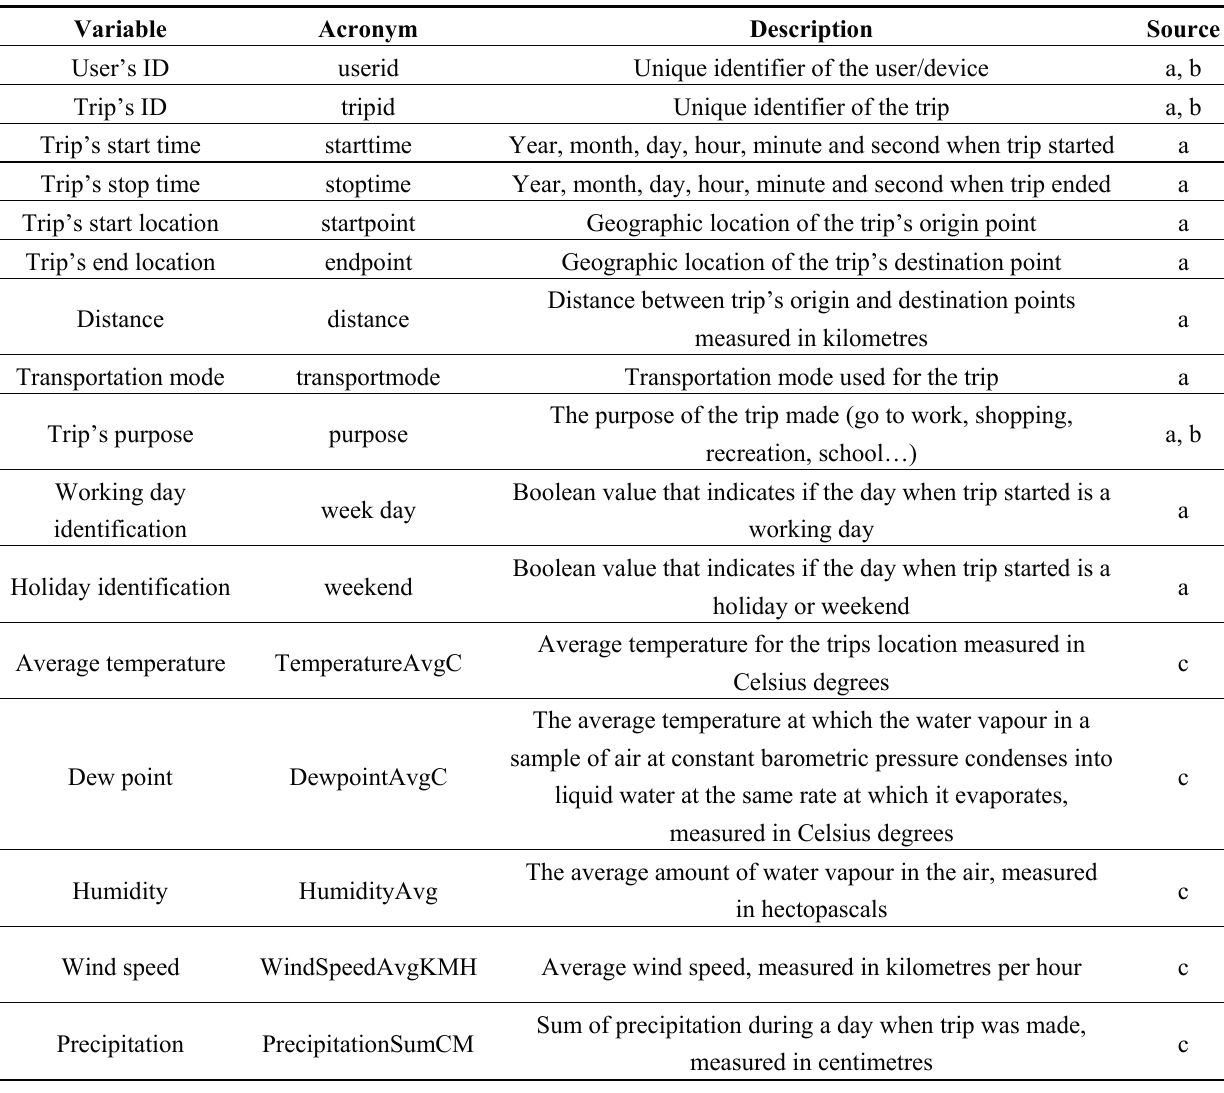
Figure 1. Distribution of trips (kilometres) made by mode ( Left ) and time of day ( Right ). Table 2. Variables used for the modelling transportation mode selection decision process.